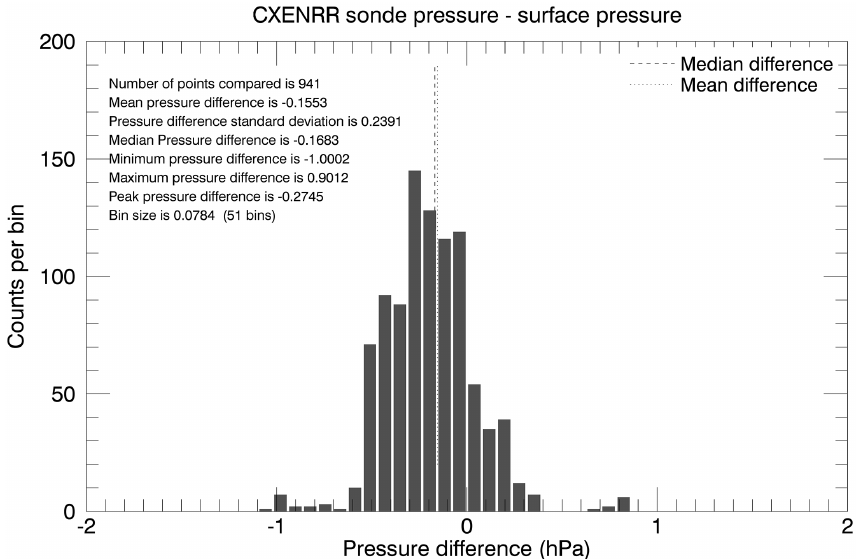
Figure 5. The distribution of the difference between 1min average Kiritimati radiosonde pressures and 1min average surface pressures when the radiosonde was co-located with the surface instruments prior to launch. All available data from 101 distinct radiosondes are